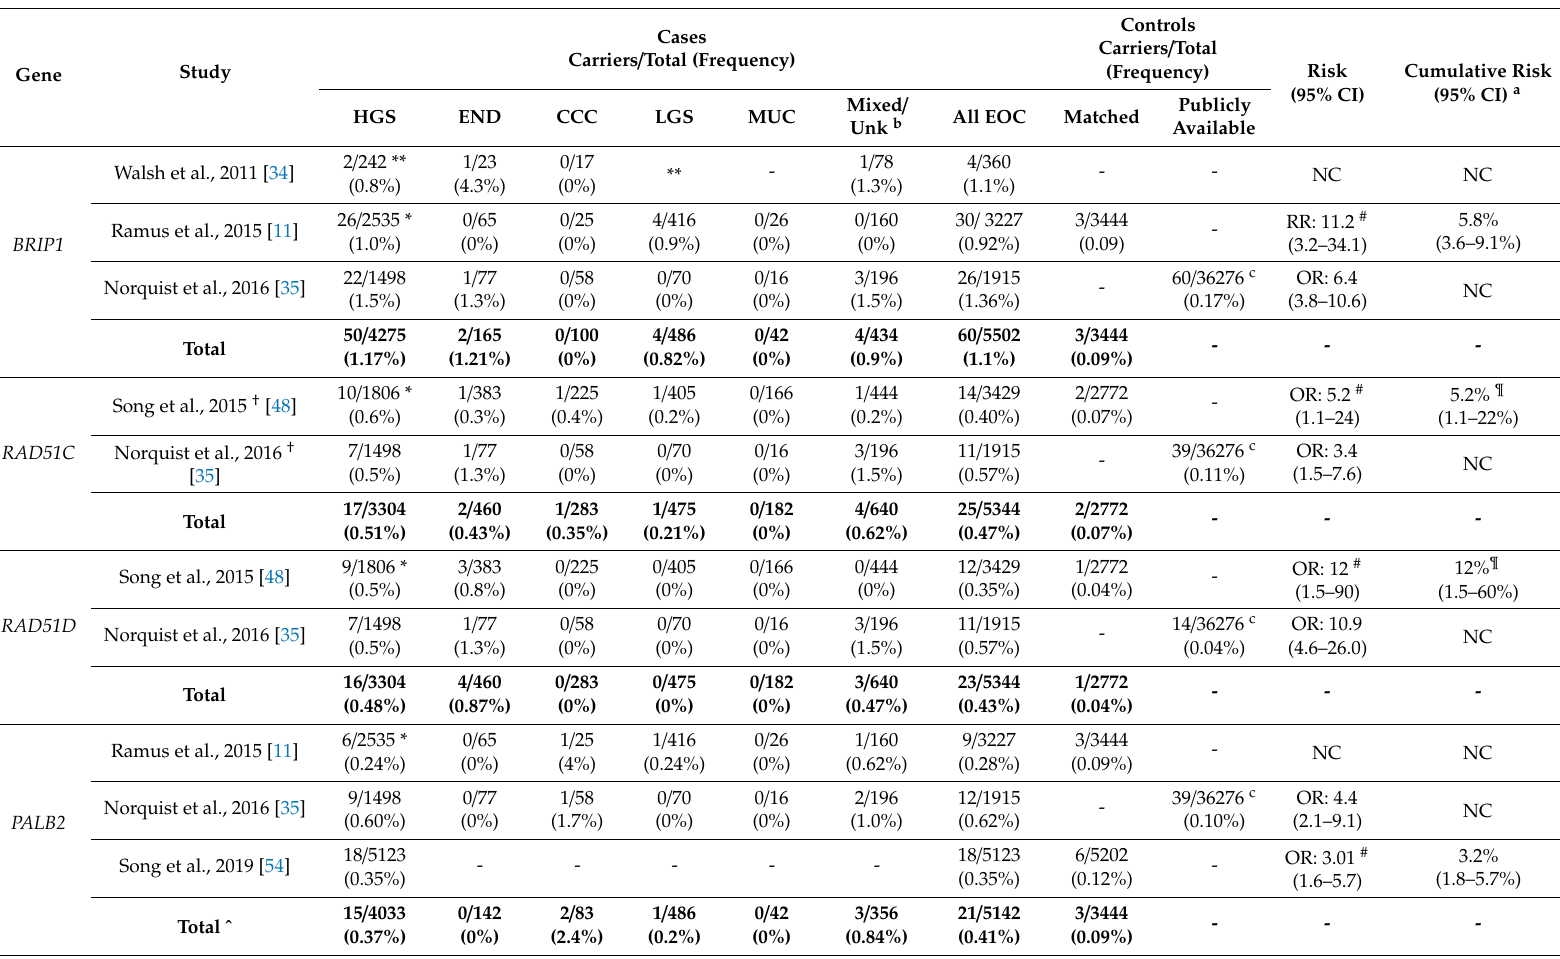
Table 3. Frequency of germline protein truncating variants in BRIP1 , RAD51C , RAD51D , and PALB2 in EOC histotypes, in cases from population